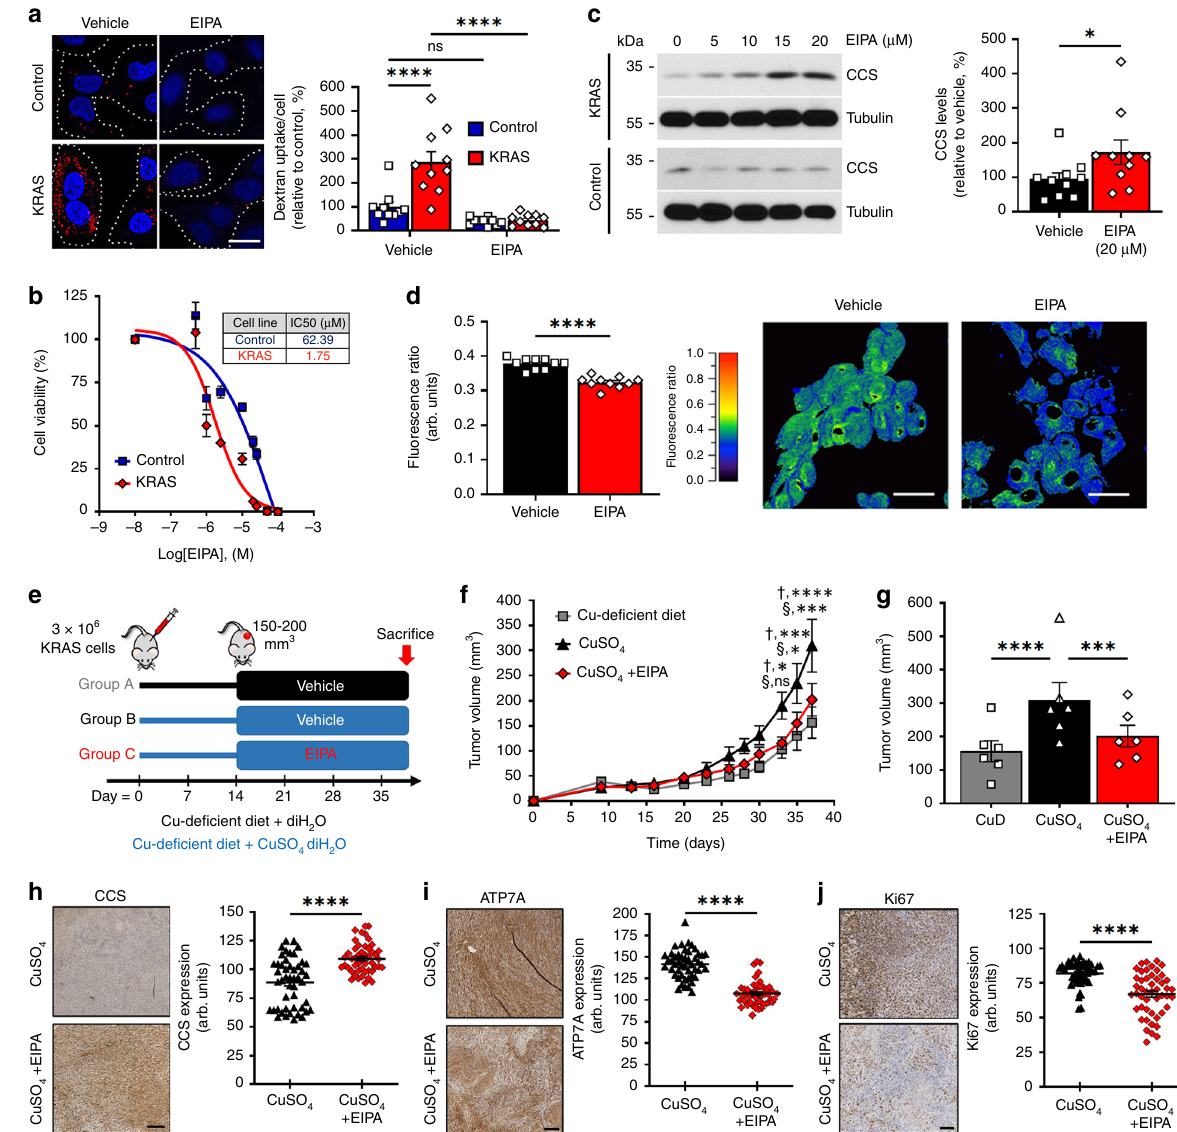
Fig. 5 Macropinocytosis is a novel Cu supply route in mutant KRAS-driven intestinal cells. a Macropinocytosis was visualized (left) and quanti fi ed (right) with TMR-dextran in Control and KRAS cells. EIPA served as negative control. White dashed lines indicate cell boundaries. Data are averaged for n > 167 cells and represent three independent experiments. ****P < 0.0001 (two-way ANOVA with post-hoc Bonferroni ’ s multiple-comparison analysis). scale = 20 μ m. b, c Control and KRAS cells were treated with EIPA at the indicated doses. b Cell viability graph with IC50 values in the adjacent table. Data are presented as relative percentage (±SEM) of living cells and represent n = 3 independent replicates. c Cell lysates were collected and CCS levels were analyzed by IB and quanti fi ed (right). Data represent n = 3 (left) and n = 10 (right)independent experiments. * P = 0.0336 (unpaired two-tailed Mann – Whitney t -test). d Graphs depicting average fl uorescence ratios of crisp-17 for KRAS cells treated with either DMSO (vehicle) or EIPA (20 µ M). Data are averaged for n = 10 cells and represent three independent experiments. Representative fl uorescence intensity images are presented (right). scale = 30 μ m. e In vivo protocol used to evaluate the role of macropinocytosis in Cu-dependent KRAS tumor growth. Mice injected with KRAS IEC-6 cells were provided with a Cu-de fi cient diet and either deionized H 2 O (diH 2 O) (Group A) or diH 2 O with CuSO 4 (Groups B and C) throughout the study. After two weeks, groups A and B were treated with vehicle and group C with EIPA for three weeks. Graphs depicting f , mean tumor volume over time and g mean tumor volume at the end of study ( n = 6 mice). P -values between Group A and B ( † , * P < 0.05; *** P < 0.001; **** P < 0.0001) and between Group B and C (§, * P < 0.05; *** P < 0.001) were determined by two-way ANOVA with post-hoc Bonferroni ’ s multiple-comparison analysis. h – j Representative images (left) and quanti fi cations (right) from immunohistochemistry pro fi ling of mouse xenograft tissues for n = 48 CCS ( h ), ATP7A ( i ), and Ki67 ( j ) random images from six mice per condition are depicted. scale = 250 μ m. For panels a – d , f – j center values and error bars represent mean ± SEM. For panels c , d , h – j * P < 0.05; **** P < 0.0001 (unpaired two-tailed Student ’ s t